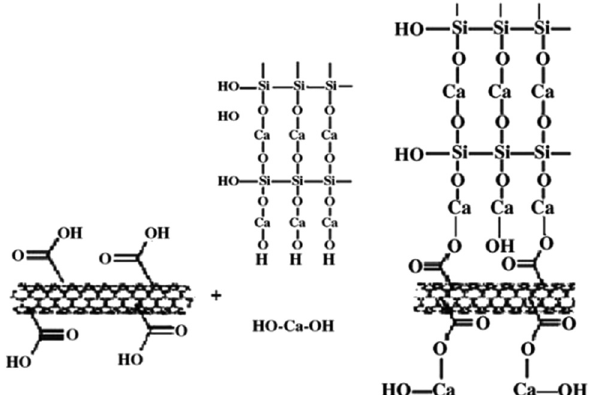
Figure 33: Reaction scheme between the carboxylated nanotubes and hydrated production ( Ca ( OH ) 2 and C – S – H ) of cement, reprinted with permission from ref. [ 20 ] ; Copyright 2005, Elsevier